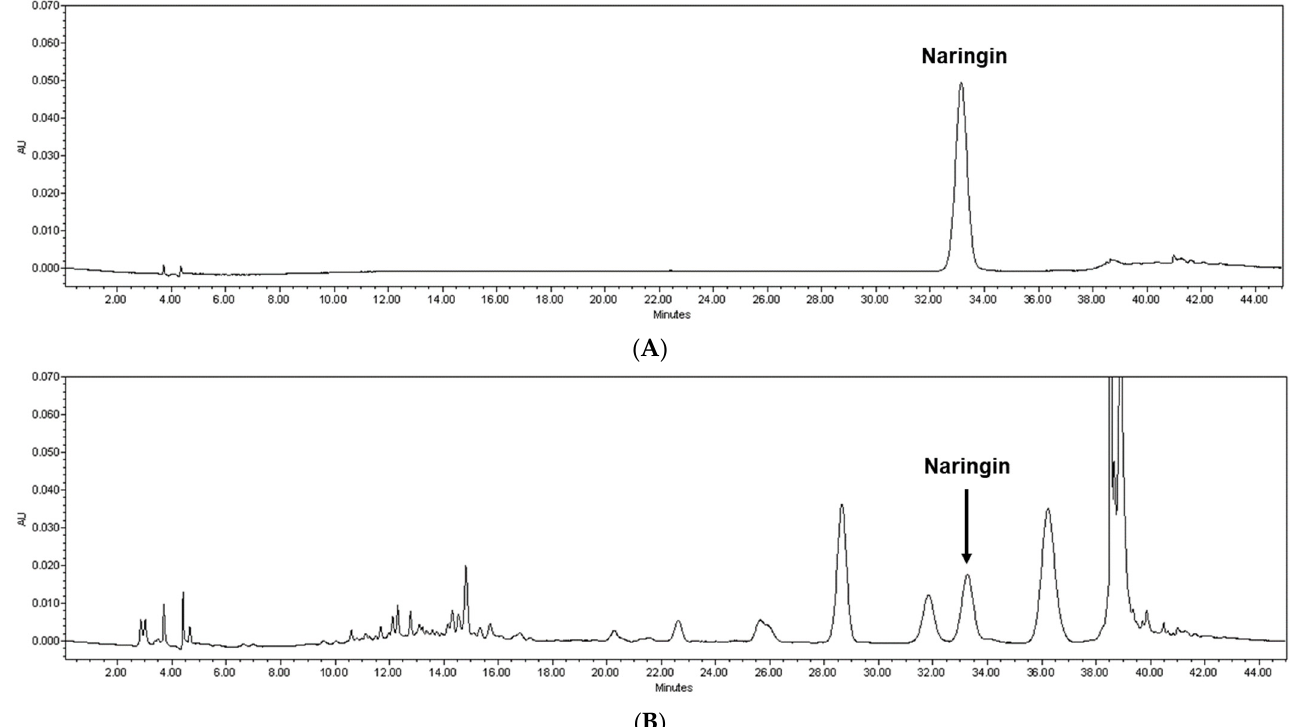
Figure 1. Quantification of naringin from CPE. Representative high-performance liquid chromatography chromatogram (at 280 nm) of the ( A ) naringin reference standard and ( B ) CPE prepared at 60 °C. The arrowed peak has been identified as naringin. CPE, Citrus junos Tanaka peel extract.